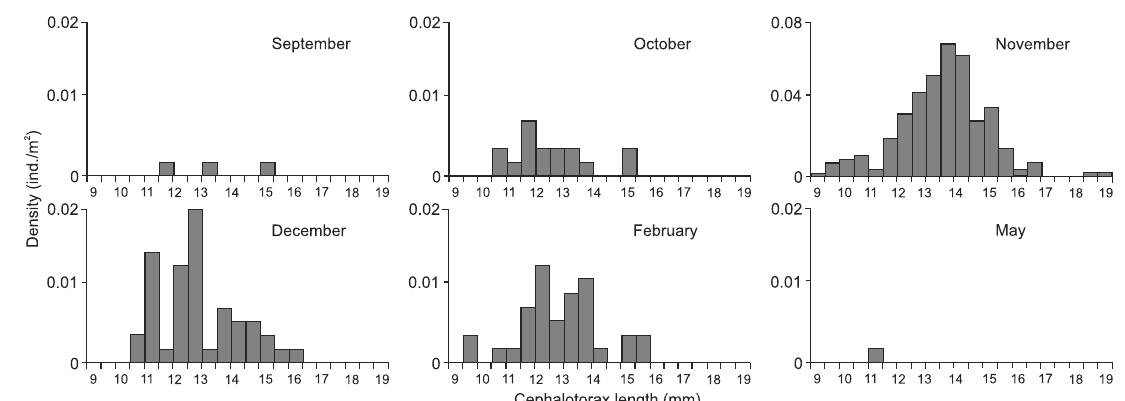
Figure 5. Density by cephalothorax length of F. subtilis in Mosqueiro, Amazon estuary of